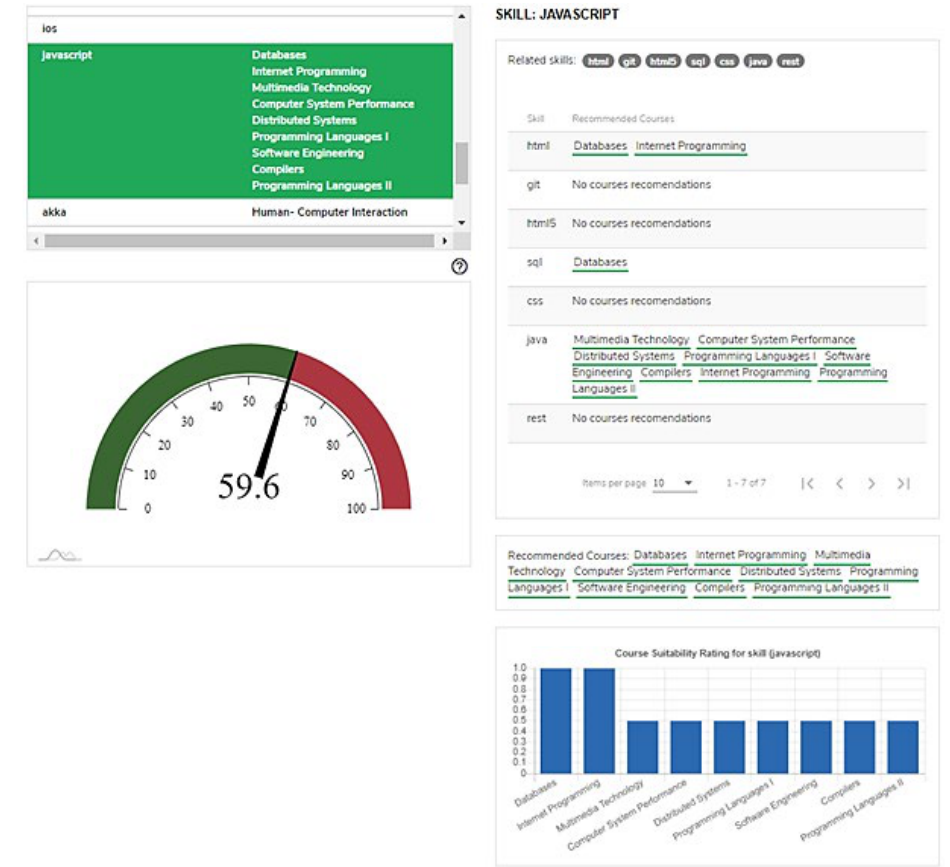
Figure 14. Curriculum Designer analytics page, emphasizing the JavaScript skill.